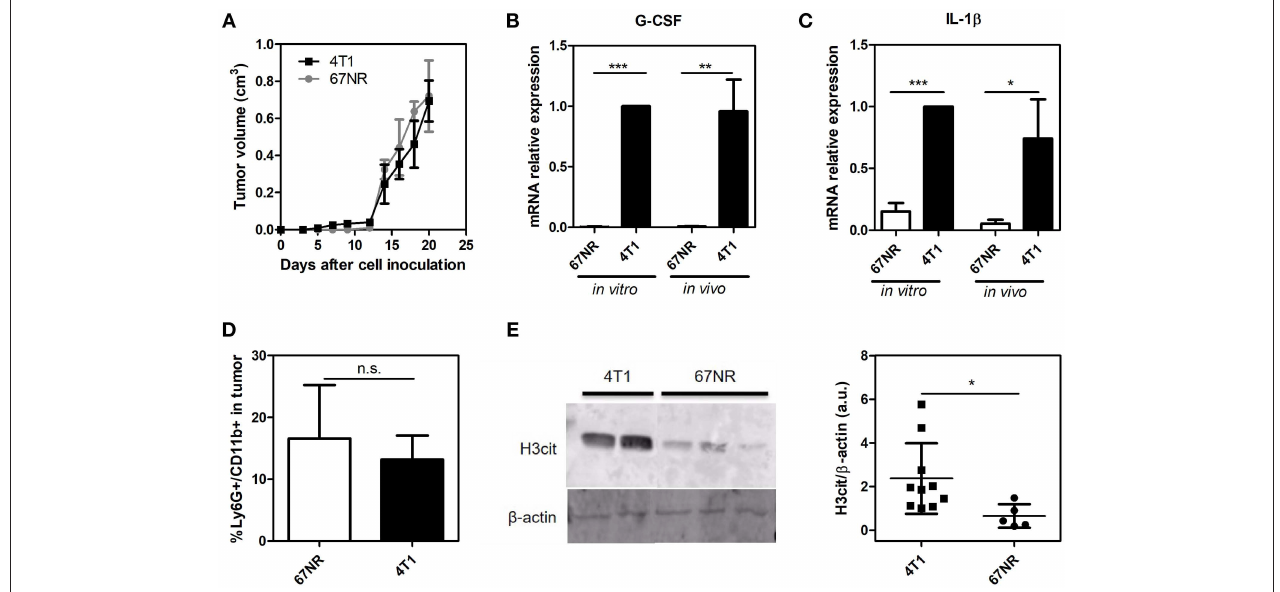
FIGURE 1 | 4T1 cells exhibit higher levels of IL-1 β , G-CSF and NET formation than 67NR cells in the tumor microenvironment. 4T1 and 67NR tumor cells (5 × 10 5 ) were orthotopically injected into the mammary fat pads of female BALB/c mice. (A) The sizes of both the 4T1 ( (cid:4) , n = 10) and 67NR (•, n = 3) tumors were monitored continuously over 21 days through measurements every 2 days. The expression of the G-CSF (B) and IL-1 β (C) genes was evaluated by qRT-PCR using 4T1 ( n = 3) and 67NR ( n = 3) tumor cells or tumor lysates from 4T1 ( n = 6) and 67NR ( n = 6) tumor-bearing mice. β -actin was used as a reference gene for normalization. The relative expression level of each mRNA was calculated using the 11 CT method. (D) The infiltration of neutrophils in 4T1 ( n = 6) and 67NR ( n = 3) tumors was analyzed 21 days after cell inoculation. The tumors were dissociated into single cells and assessed for Ly6G + CD11b + cells via flow cytometry. (E) To evaluate the presence of NETs in the tumor microenvironment, the levels of citrullinated histone (H3cit) were investigated by Western blotting proteins from 4T1 ( n = 10) and 67NR ( n = 5) tumors. The right panel shows the quantification of H3cit protein levels normalized to β -actin levels. For the original uncropped western blot data (see Supplementary Information ). Each dot represents one individual mouse. Values represent the mean ± SD. * P < 0.05, ** P = 0.01, and *** P = 0.001; n.s., non-significant, unpaired two-tailed Student’s t